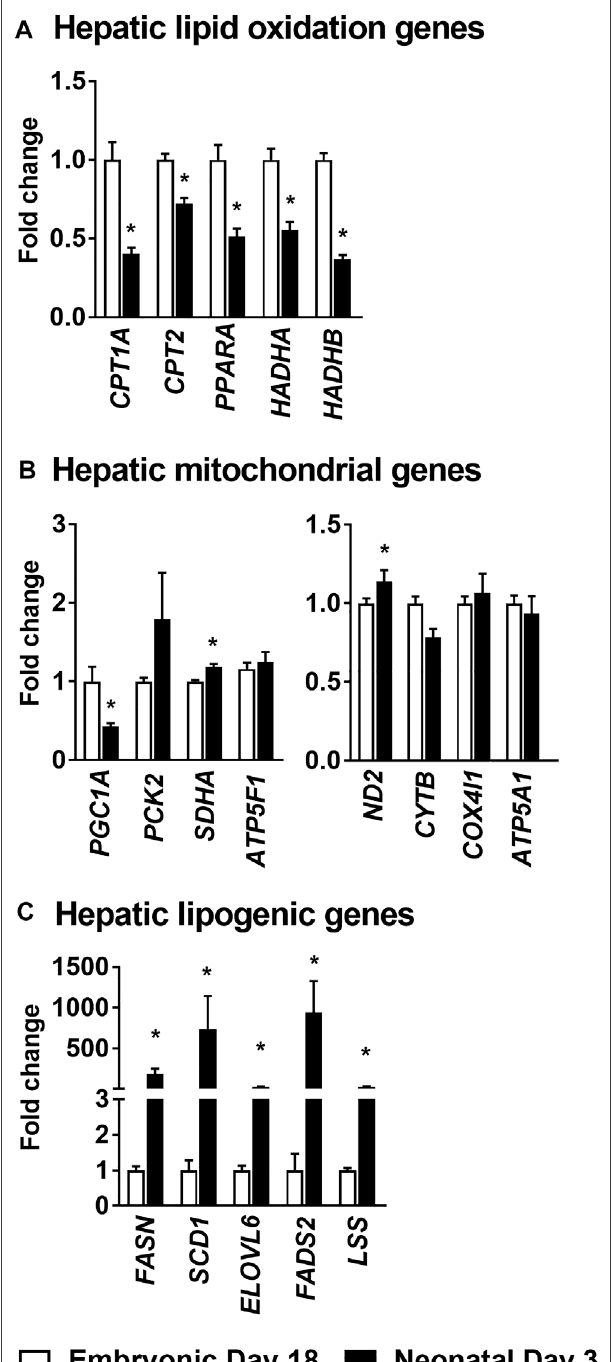
FIGURE 3 | considered signi fi cant at p ≤ 0.05 (*) following a Student t -test between embryonic day 18 and neonatal day 3. CPT1A , Carnitine